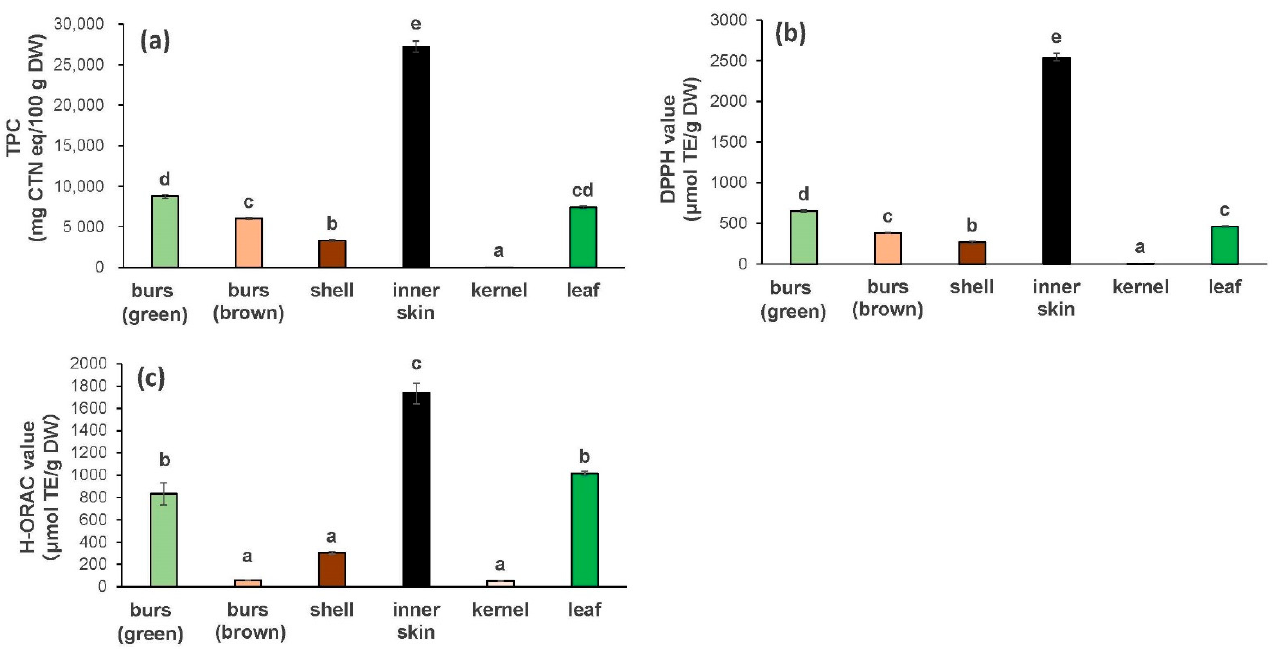
Figure 2. Antioxidant activity of ‘Porotan’ chestnut components. Antioxidant activity was evaluated as the TPC ( a ), DPPH radical scavenging activity ( b ), and H-ORAC ( c ). TPC, total polyphenol content; DPPH, 2,2-diphenyl-1-picrylhydrazyl radical scavenging activity; H-ORAC, hydrophilic oxygen radical absorbance capacity. Means are shown, with vertical bars indicating standard error ( n = 6). The different letters (a–e) indicate statistical differences ( p < 0.05). Table 1. Antibacterial properties of ‘Porotan’ chestnuts against different bacteria.